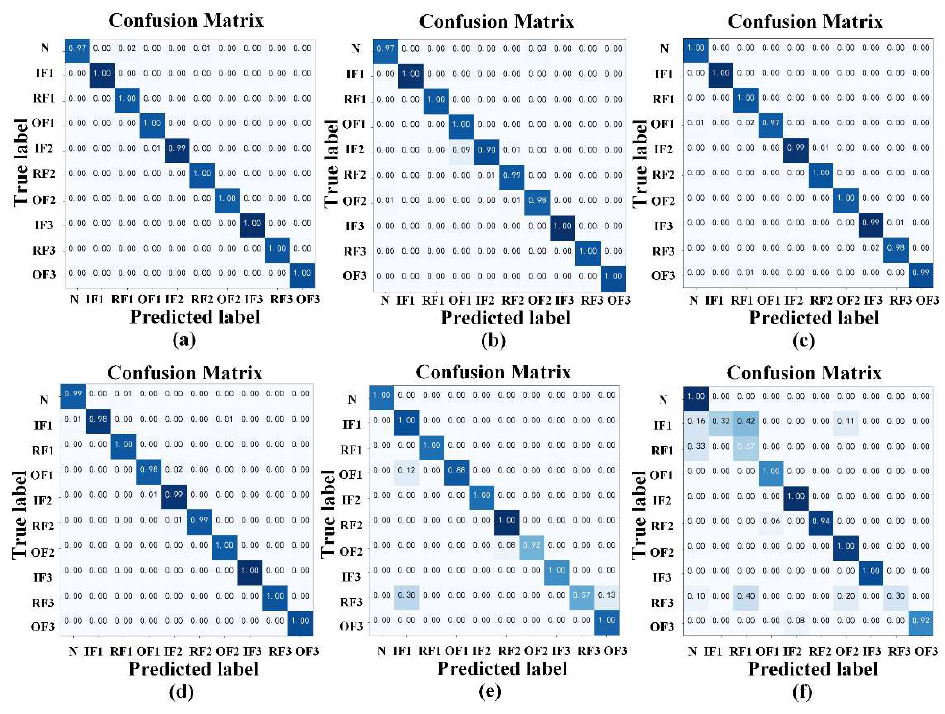
Figure 16. The confusion matrix of different diagnostic results on dataset A, ( a ) The proposed method, ( b ) GAF-SE-CNN, ( c ) GAF-CBAM-CNN, ( d ) GAF-BAM-CNN, ( e ) VMD-Gray image-Resnet50, ( f ) EMD-Gray image-Resnet50.